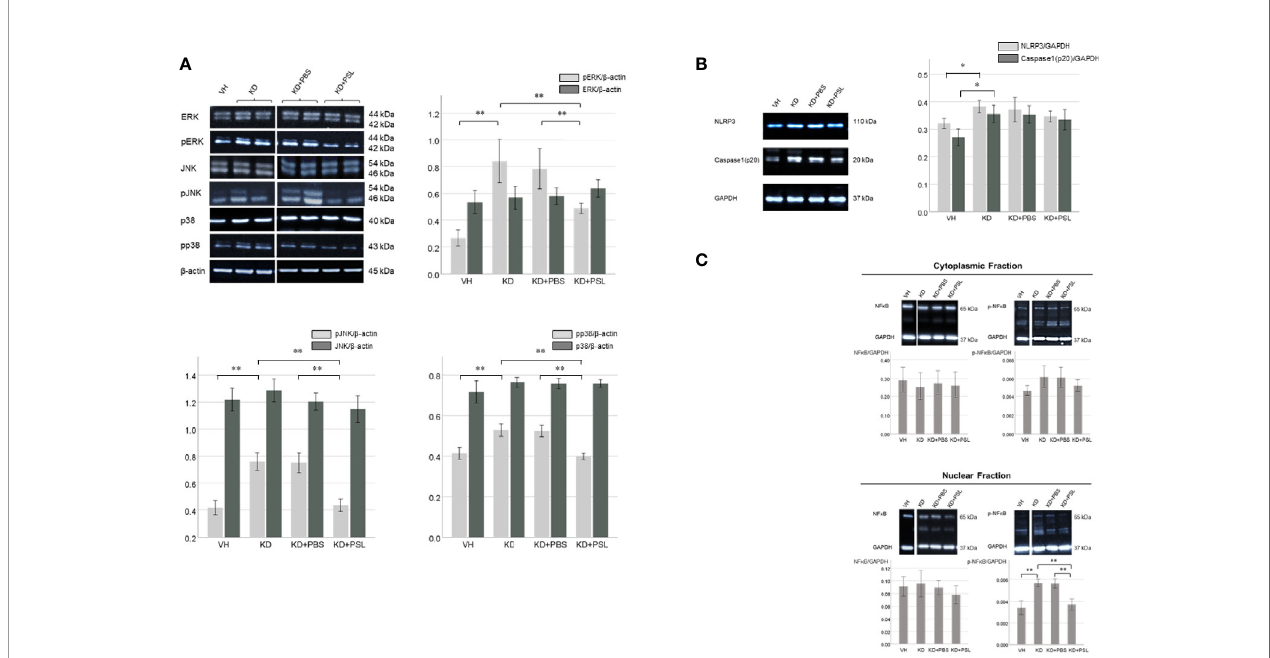
FIGURE 4 | ERK1/2, JNK, p38 and NF- k B levels in serum-activated human coronary artery endothelial cells (HCAECs). (A) Western blot analysis of ERK1/2, pERK1/2, JNK, pJNK, p38 and pp38 from healthy controls (VH, n = 4), Kawasaki disease (KD, n = 8), KD serum-activated HCAECs treated with PBS and prednisolone (PSL) (KD+PBS and KD+PSL, n = 8, respectively). Bar graph shows immunoblotting results for the ERK1/2: b -actin, pERK 1/2: b -actin, JNK: b -actin, pJNK: b -actin, p38: b -actin and pp38: b -actin ratio ** P < 0.01 (one-way ANOVA followed by the Bonferroni, post-test). (B) NLRP3 and Caspase-1(p20) in serum- activated HCAECs from healthy controls (VH, n = 4), KD ( n = 8), and KD serum-activated HCAECs treated with PBS and PSL (KD+PBS and KD+PSL, n = 8, respectively). Bar graphs show immunoblotting results for NLRP3:GAPDH and Caspase-1(p20):GAPDH ratio in HCAEC lysates. * P < 0.05 (Kruskal – Wallis test followed by Dunn ’ s post-test). (C) Cytoplasmic and nuclear NF- k B and p-NF- k B in serum-activated HCAECs from healthy controls (VH, n = 4), KD ( n = 8), and KD serum-activated HCAECs treated with PBS and PSL (KD+PBS and KD+PSL, n = 8, respectively). Bar graphs show immunoblotting results for NF- k B:GAPDH and p-NF- k B:GAPDH ratio in HCAEC lysates. ** P < 0.01 (Kruskal – Wallis test followed by Dunn ’ s